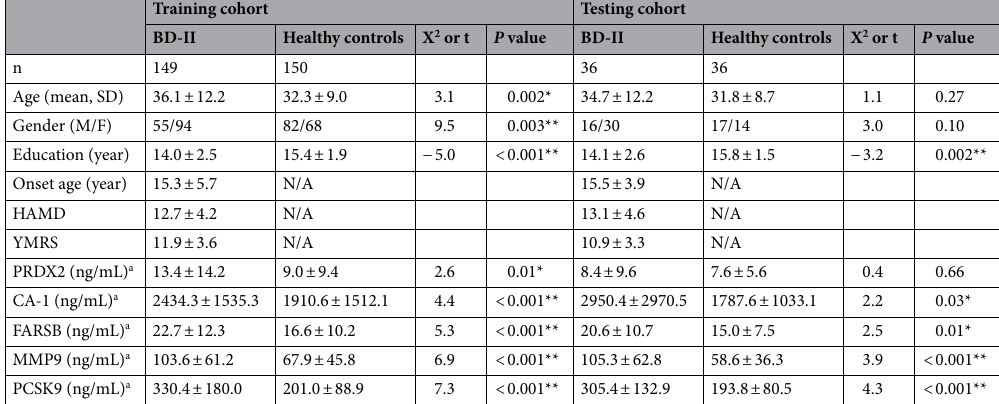
Table 1. Clinical and demographic data of patients with bipolar II disorder (BD-II) and healthy controls. We used t-test for continuous variables and chi-square test for categorical variables. HAMD Hamilton